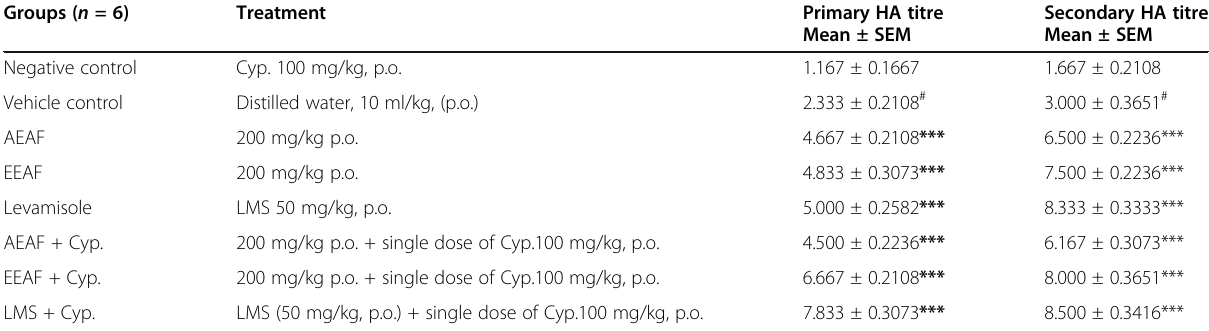
Table 7 Effect of aqueous and ethanolic extract of A . ficulneus L. leaves on specific primary and secondary antibody response in mice